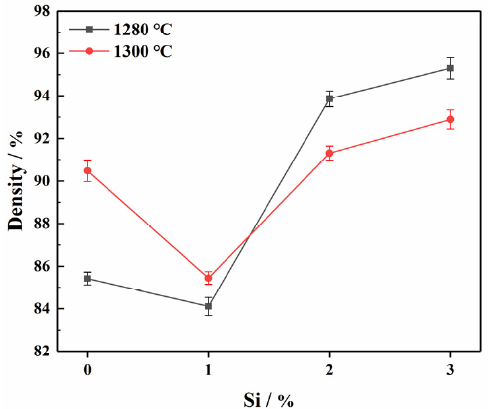
Figure 3. Density of ODS steels with 0, 1%, 2% and 3%wt Si at 1280 °C and 1300 °C sintering tem- perature.